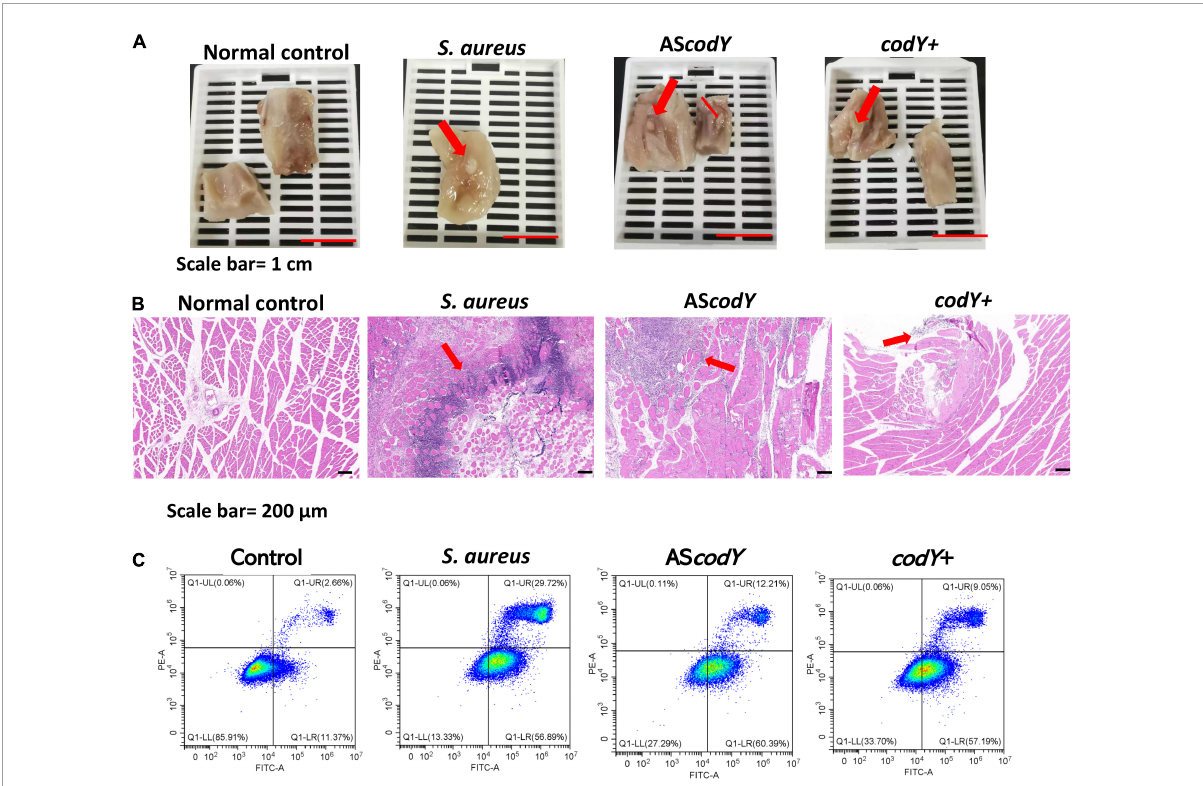
FIGURE6 CodY impedes pathogenicity in a rat-infection model. (A) Gross observation of the abscess in S. aureus , codY + and codY - infected group; scale bars, 1 cm. (B) HE staining of the abscess lesions in S. aureus , codY + and codY - infected group; scale bars, 200 µ m. (C) The apoptosis rates of macrophage cells when co-cultured with S. aureus , codY + and codY - respectively were measured by the flow